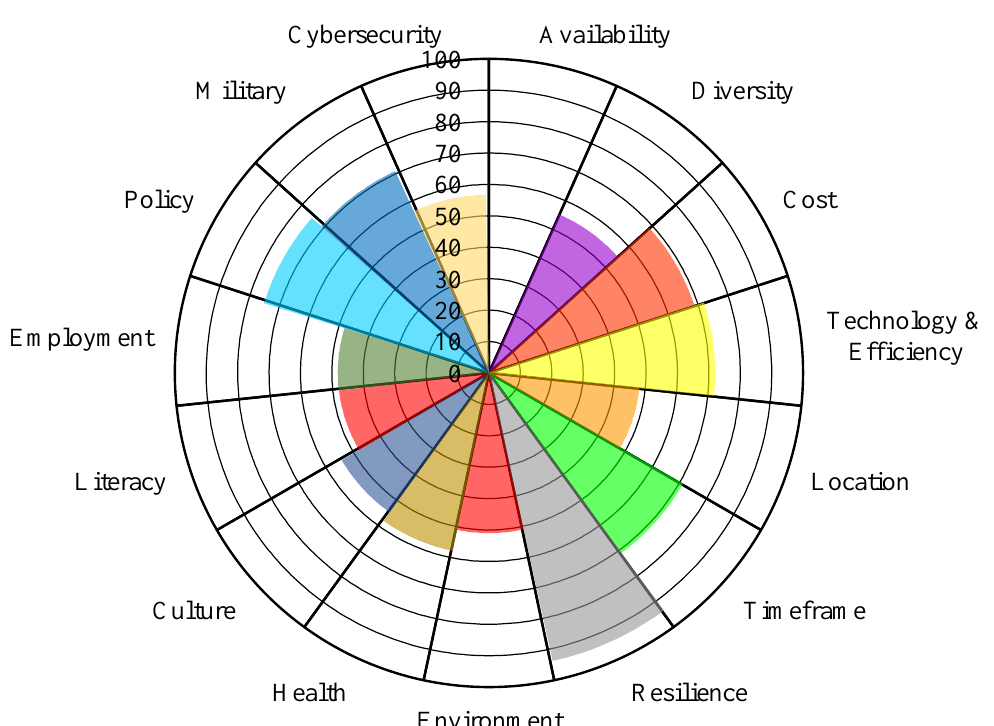
Figure 18. Detailed energy security view for Germany, values 0–100 represent worst to best.